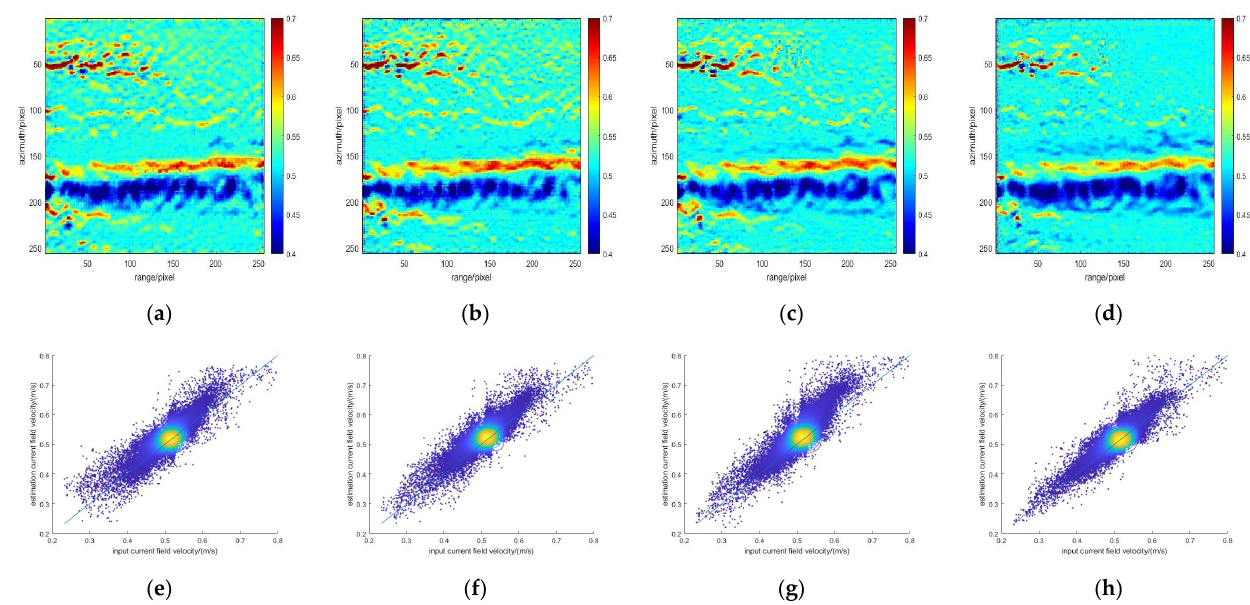
Figure 10. The estimation velocity of ocean surface currents under the different sample sizes from ( a – d ): ( a ) 100 samples, ( b ) 200 samples, ( c ) 300 samples, and ( d ) 400 samples. The scatter density map between the estimation velocity of the ocean surface currents and the control group velocity of the input ocean surface currents under the different sample sizes from ( e – h ): ( e ) 100 samples, ( f ) 200 samples, ( g ) 300 samples, and ( h ) 400 samples. Table 6. Statistics of the estimation results under different sample numbers. (4)